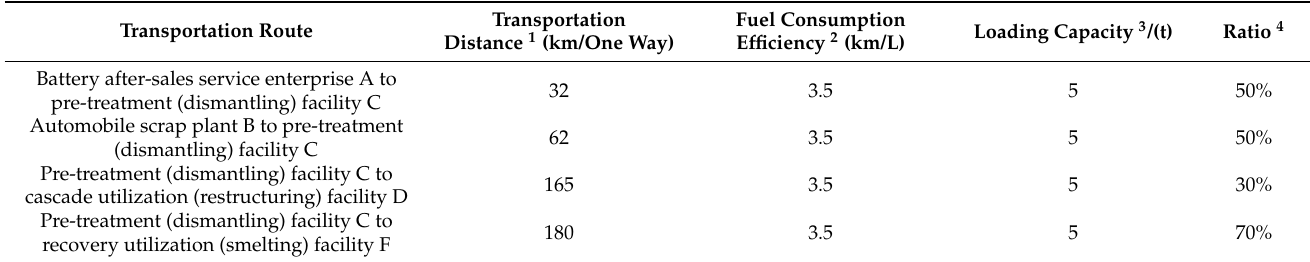
Table 1. The logistic chain of LIB recycling.